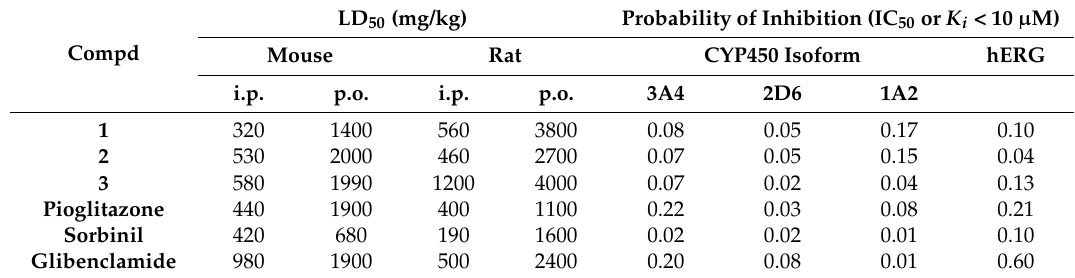
Table 3. Toxicity profiles predicted for compounds 1 – 3 , pioglitazone, sorbinil and glibenclamide.